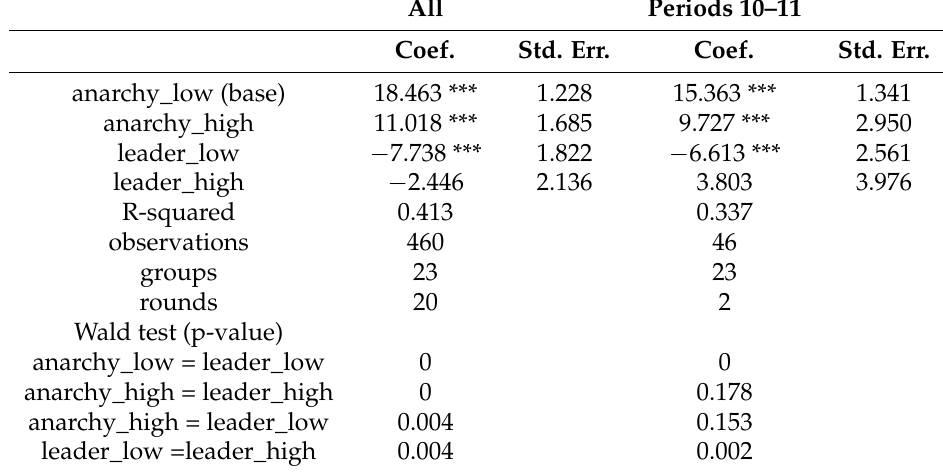
Table 4. Impact of resource size and institutions on conflict. Random error-Generalized least squares regression with robust standard errors clustered across groups; Dependent variable: group